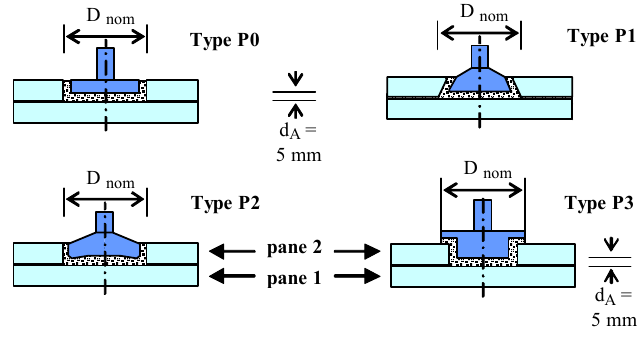
Figure 8: Overview of investigated point support designs.